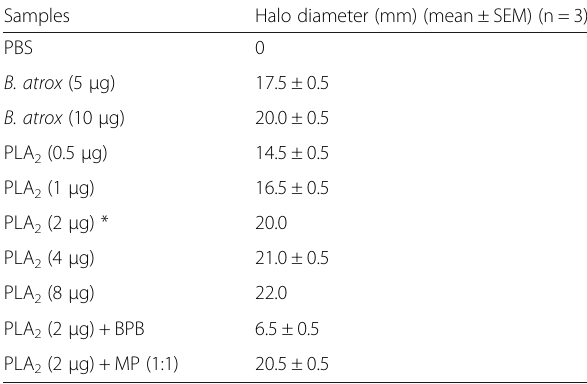
Table 1 Phospholipase activity of B. atrox venom and